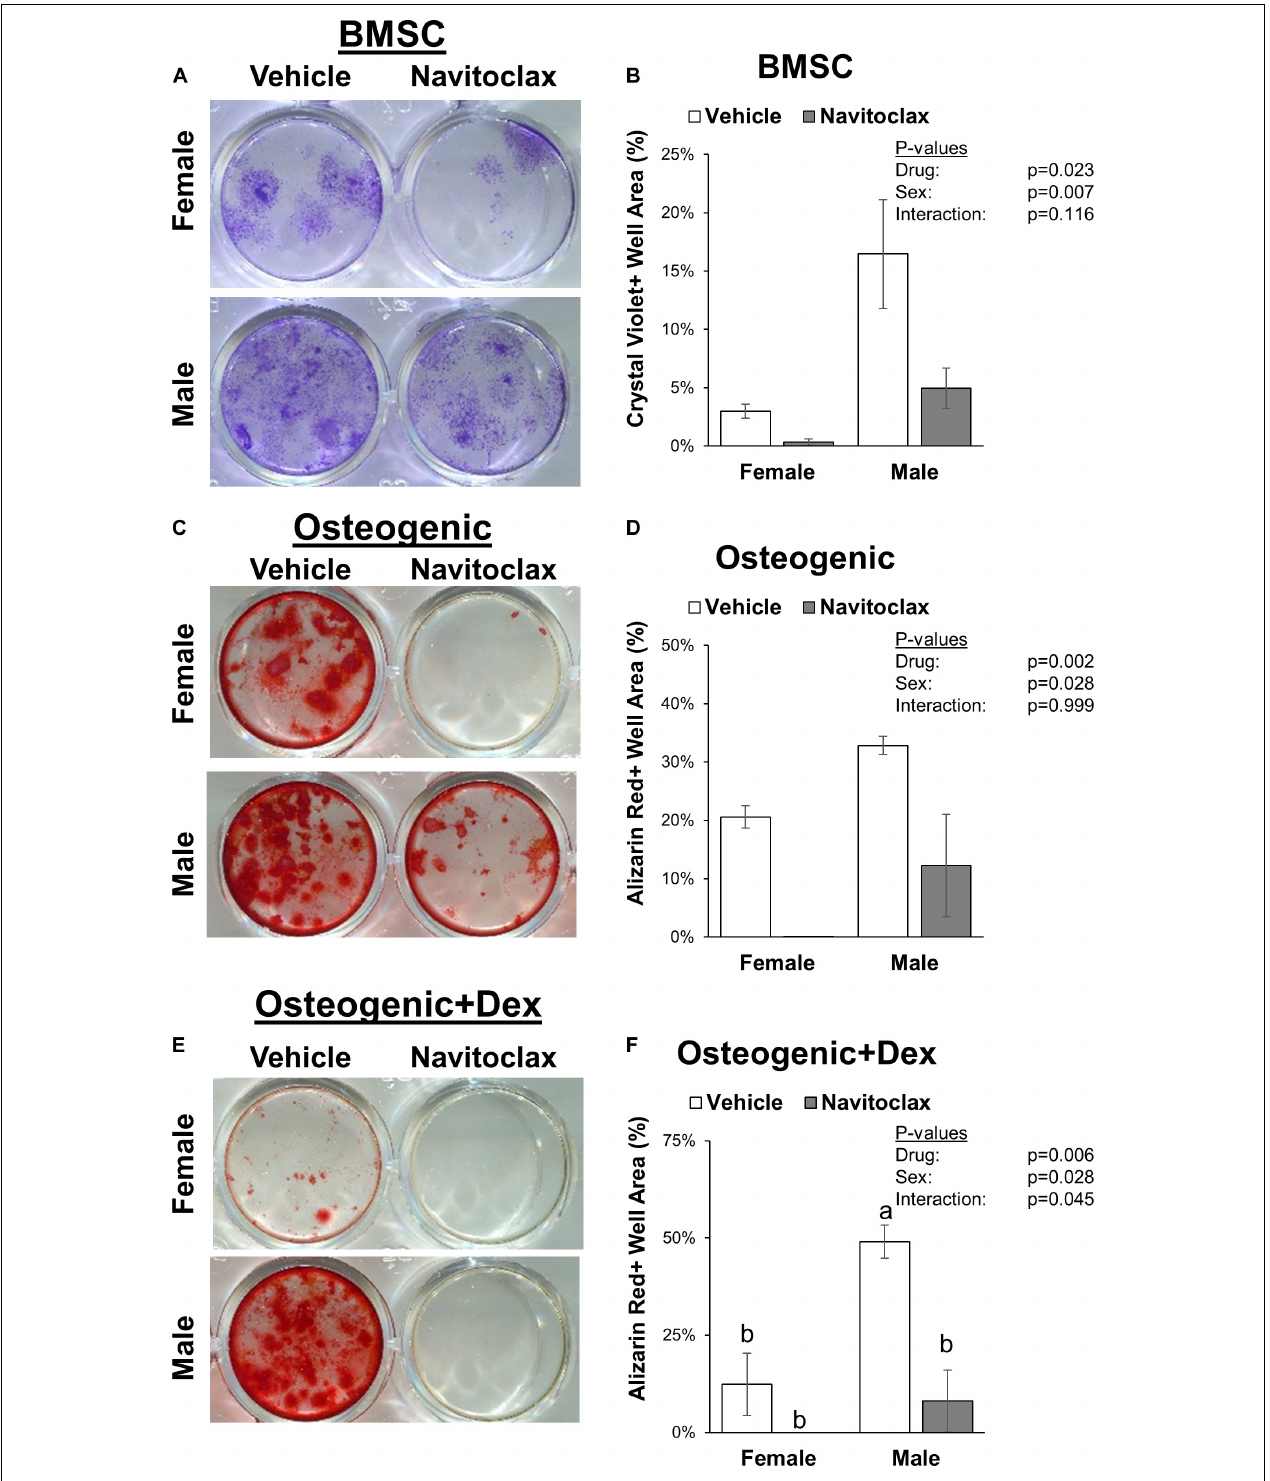
FIGURE 3 | Navitoclax impaired colony formation and mineralized matrix production. Primary BMSC were treated with navitoclax (5 µ M) or vehicle (DMSO) for 21 days in BMSC growth medium (A,B) , osteogenic medium (C,D) , or osteogenic medium with 100 nM dexamethasone (E,F) . Colony growth and matrix production were quantified as the fractional area of the well with staining after 21 days. Representative wells for each condition are shown in (A,C,E) . P -values shown represent statistical comparisons between groups, p -value for “drug” in 2-factor ANOVAs represents the comparison between navitoclax (gray) and vehicle (white)-treated